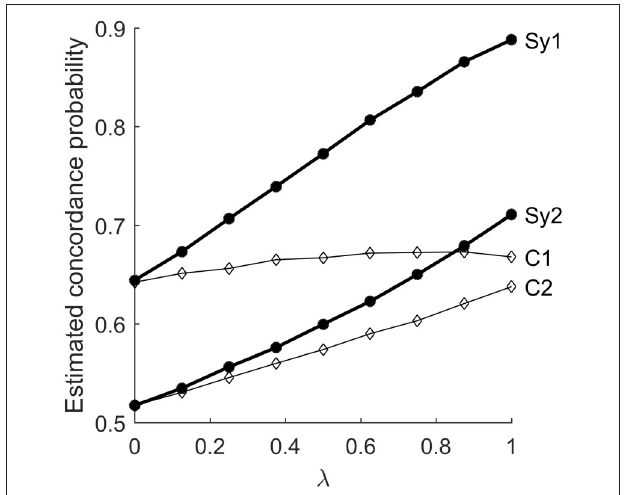
FIGURE 8 | Estimated concordance probability of edges in subgraphs G 1 and G 2 , vs. λ . C1 and C2 are the results for subgraphs 1 and 2, respectively, using the centered zero/one model. Sy1 and Sy2 are the corresponding curves for the symmetric